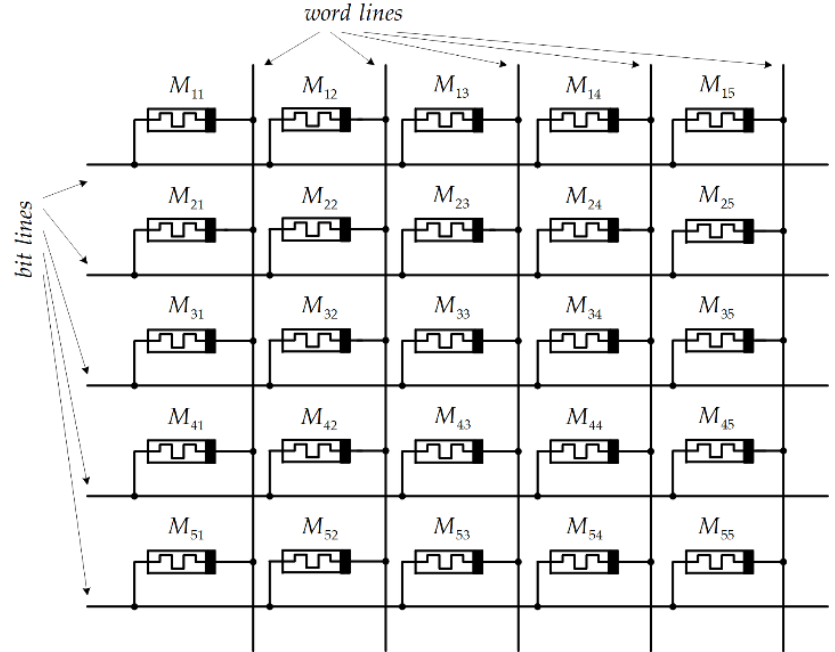
Figure 3. A passive memristor memory crossbar.